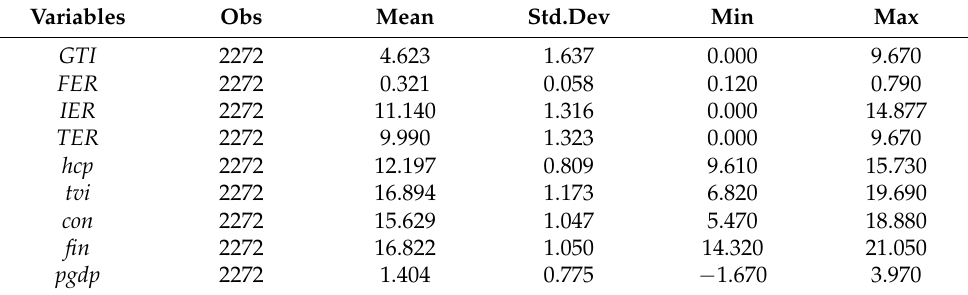
Table 2. Descriptive statistics of variables.